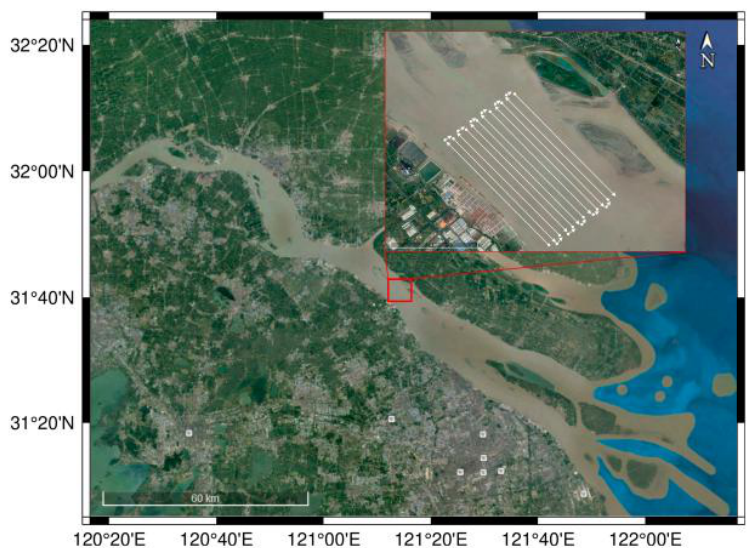
Remote Sens. 2021 , 13 , 3555 Figure 16. The schematic diagram of the sailing routes of SSS measurement.